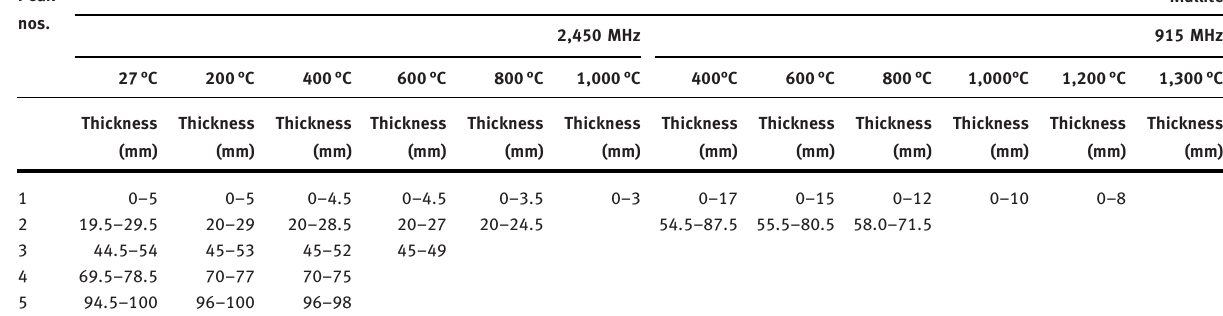
Table 3: The thickness ranges of the power transmission coefficient more than 70%.